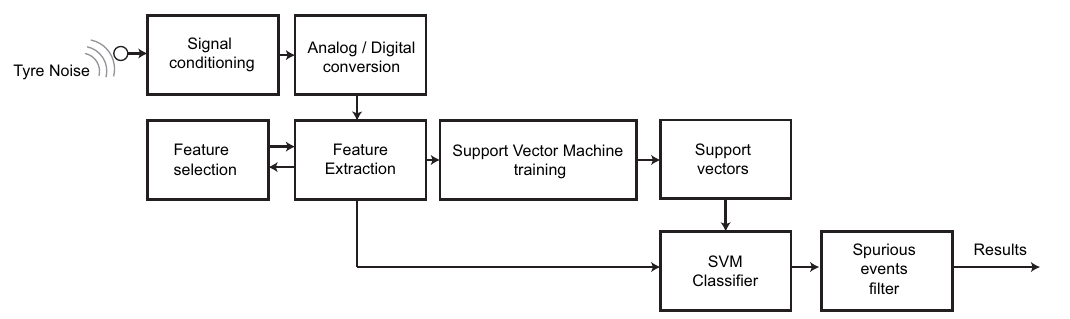
Figure 23. Block diagram of the road friction characterisation system presented in Alonso et al. [49]. Figure adapted by the authors from [49].